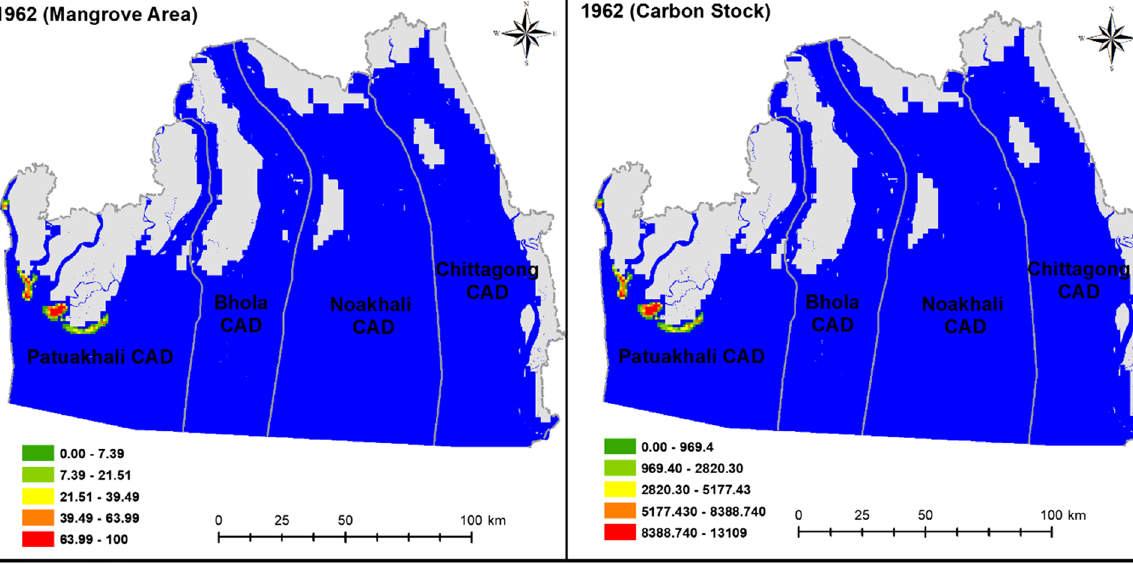
Fig. 14 Mangrove area and carbon stock in